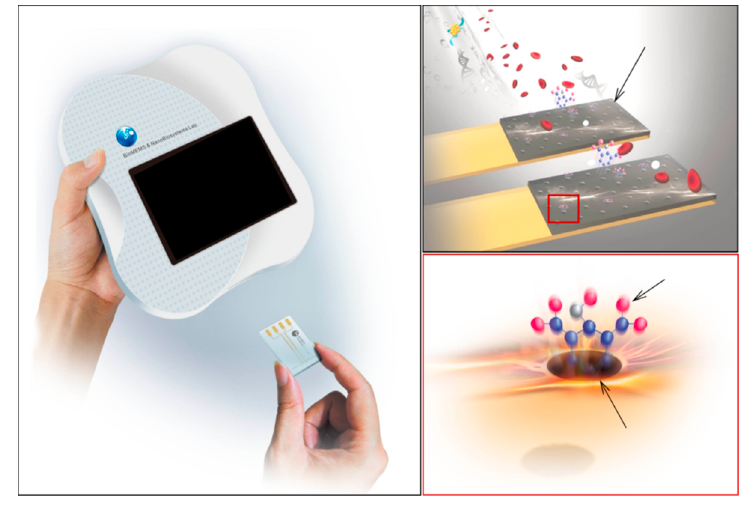
Figure 7. The propofol sensing system. Republished with permission from Hong et al. [56].